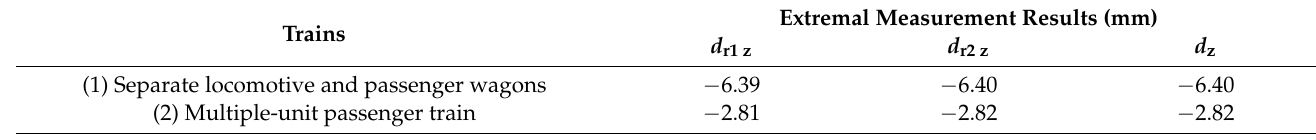
Table 2. Bridge No. 2—summary of comparative